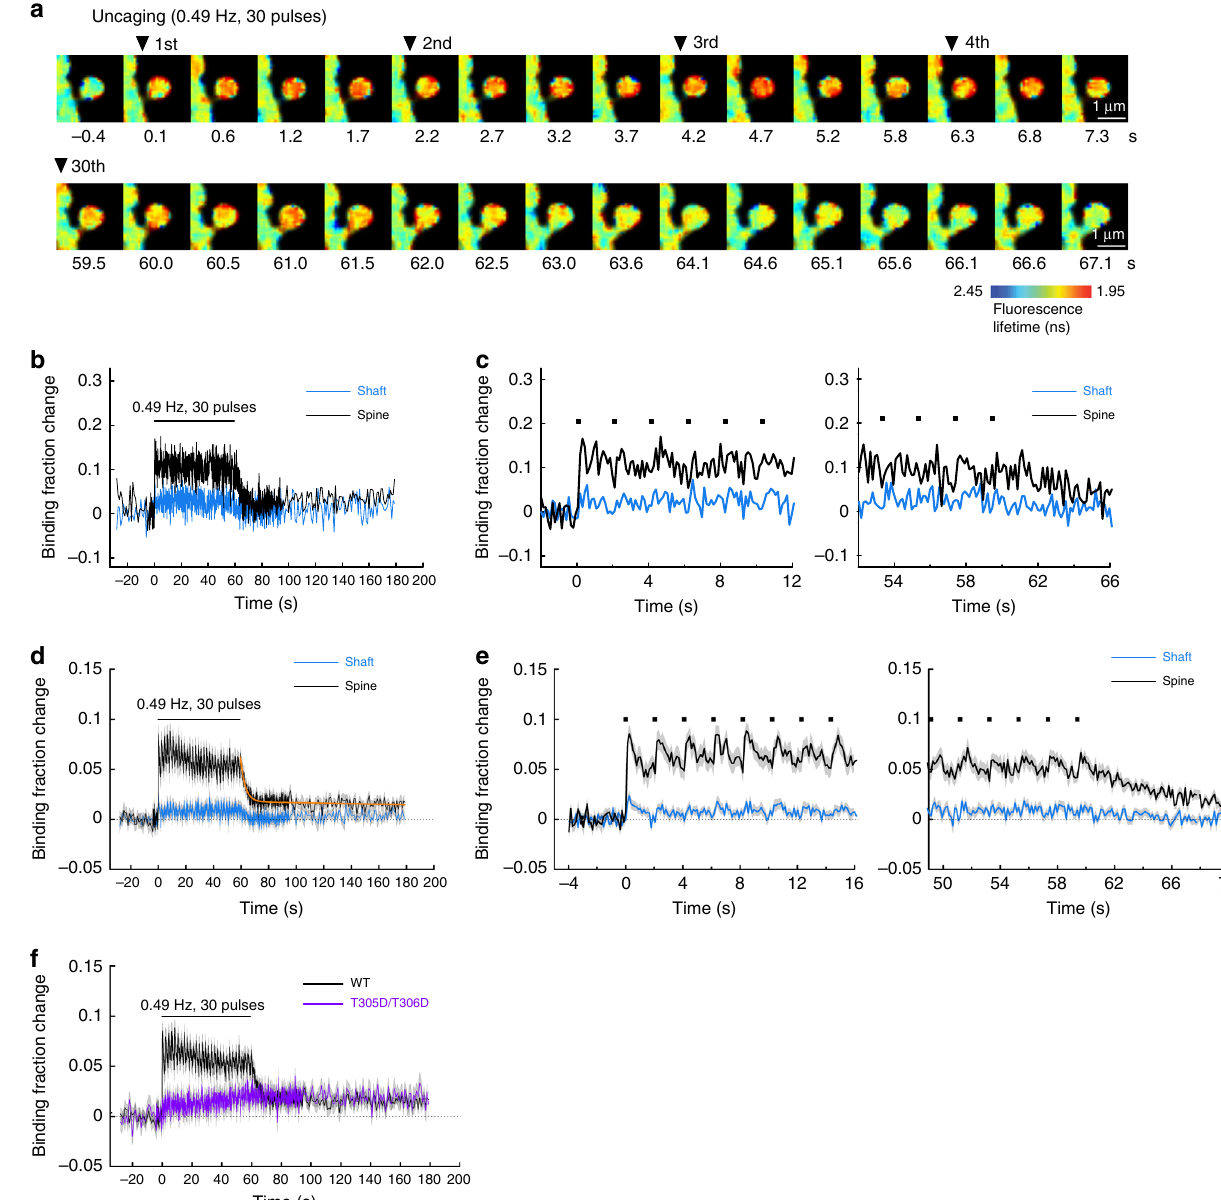
Fig. 2 CaMKII α -CaM association during sLTP induction. a Representative fl uorescence lifetime images of CaMKII α -CaM association sensor during glutamate uncaging at 0.49 Hz. Warmer colors indicate lower fl uorescence lifetime, corresponding to a higher binding fraction of mCherry-CaM to mEGFP- CaMKII α . Scale bar, 1 µ m. b Time course of CaMKII α -CaM association in a stimulated spine (black) and nearby dendrite (blue). Analyzed from images in a . Black dots represent uncaging pulses. c Expanded view of the rising phase (left) and the decay phase (right) of b . d Averaged change in CaMKII α -CaM association in stimulated spines (black) and nearby dendrite (blue) ( n = 27 spines/9 neurons). The orange curve indicates the decay of binding fraction change obtained by curve fi tting of a double-exponential function: B ( t ) = B 0 [ P fast · exp( – t / τ fast ) + P slow · exp( – t / τ slow )], where B 0 is the initial binding fraction change, τ fast and τ slow are the fast and slow decay time constants and P fast and P slow are the respective populations. The time constants are obtained as τ fast = 3.2 ± 0.6 s ( P = 71%) and τ = 572 ± 843 s ( P = 29%). e Expanded view of the rising phase (left) and the decay phase (right) of d . f Average fast slow slow time course of CaMKII α -CaM association for a mutant mEGFP-CaMKII α T305D/T306D in which the Thr305 and Thr306 are mutated to aspartate. The mutation precludes Ca 2 + /CaM binding in the stimulated spine during glutamate uncaging at 0.49 Hz (purple; n = 34 spines/5 neurons). The data for CaMKII α WT (black) are from c for the comparison. All data are shown in mean ± sem, and sem of time constants is obtained by